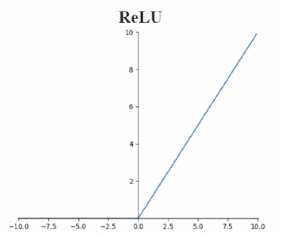
Figure 1. ReLU activation